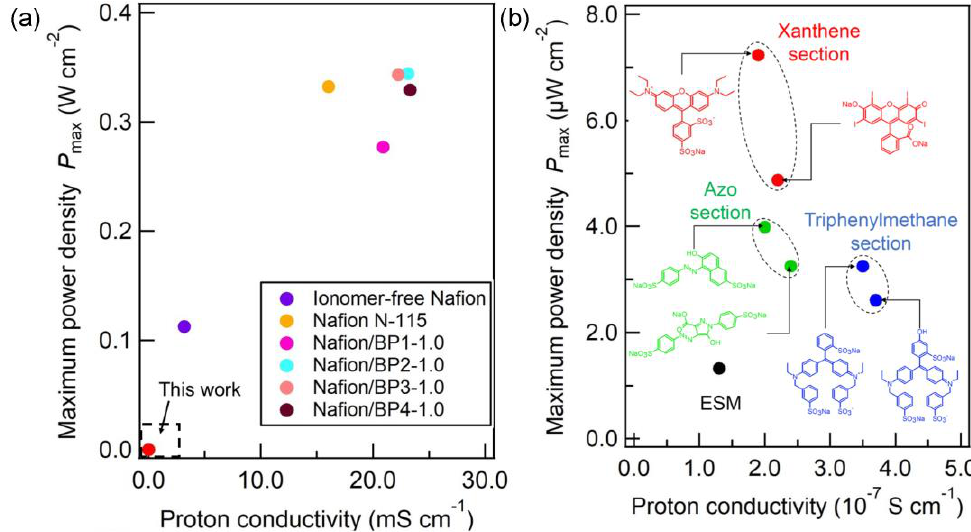
Figure 6. The correlation between the proton conductivities and the maximum power densities of ionomer-free Nafion-based PEMFCs [24,25] ( a ) and dye-ESM composites ( b ).